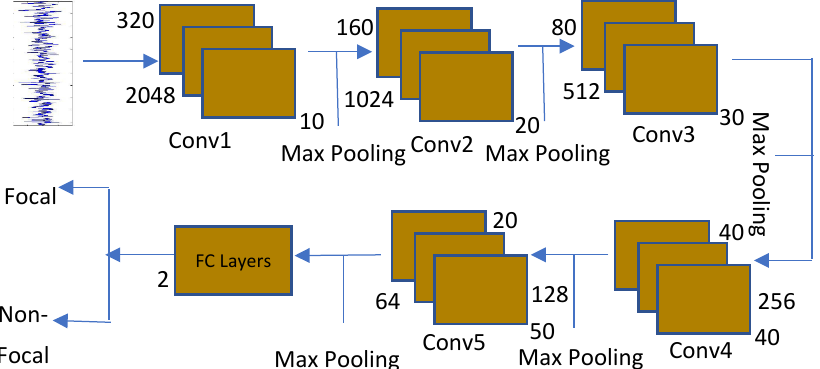
Figure 3. Architecture of 2D-DCNN for classification of focal and non-focal EEG using time-frequency WT-SST features.